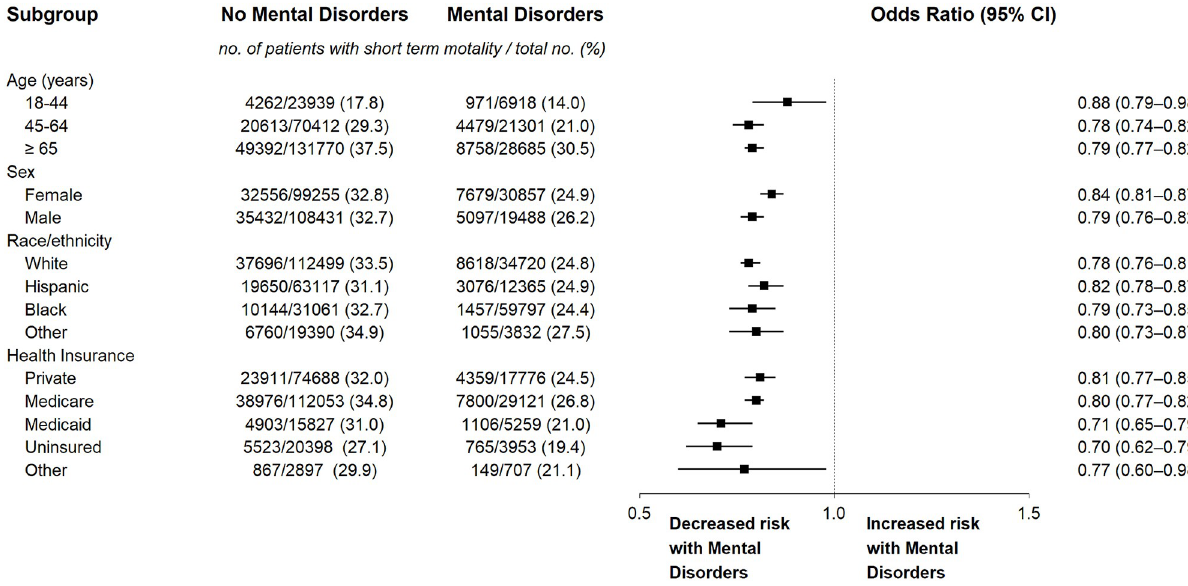
Fig 1. Subgroup analyses of short-term mortality of septic hospitalizations with and without mental disorders. Analyses were done using multilevel multivariable logistic regression with propensity adjustment. The odds ratios and 95% confidence intervals have not been adjusted for multiplicity and should not be used to infer definite